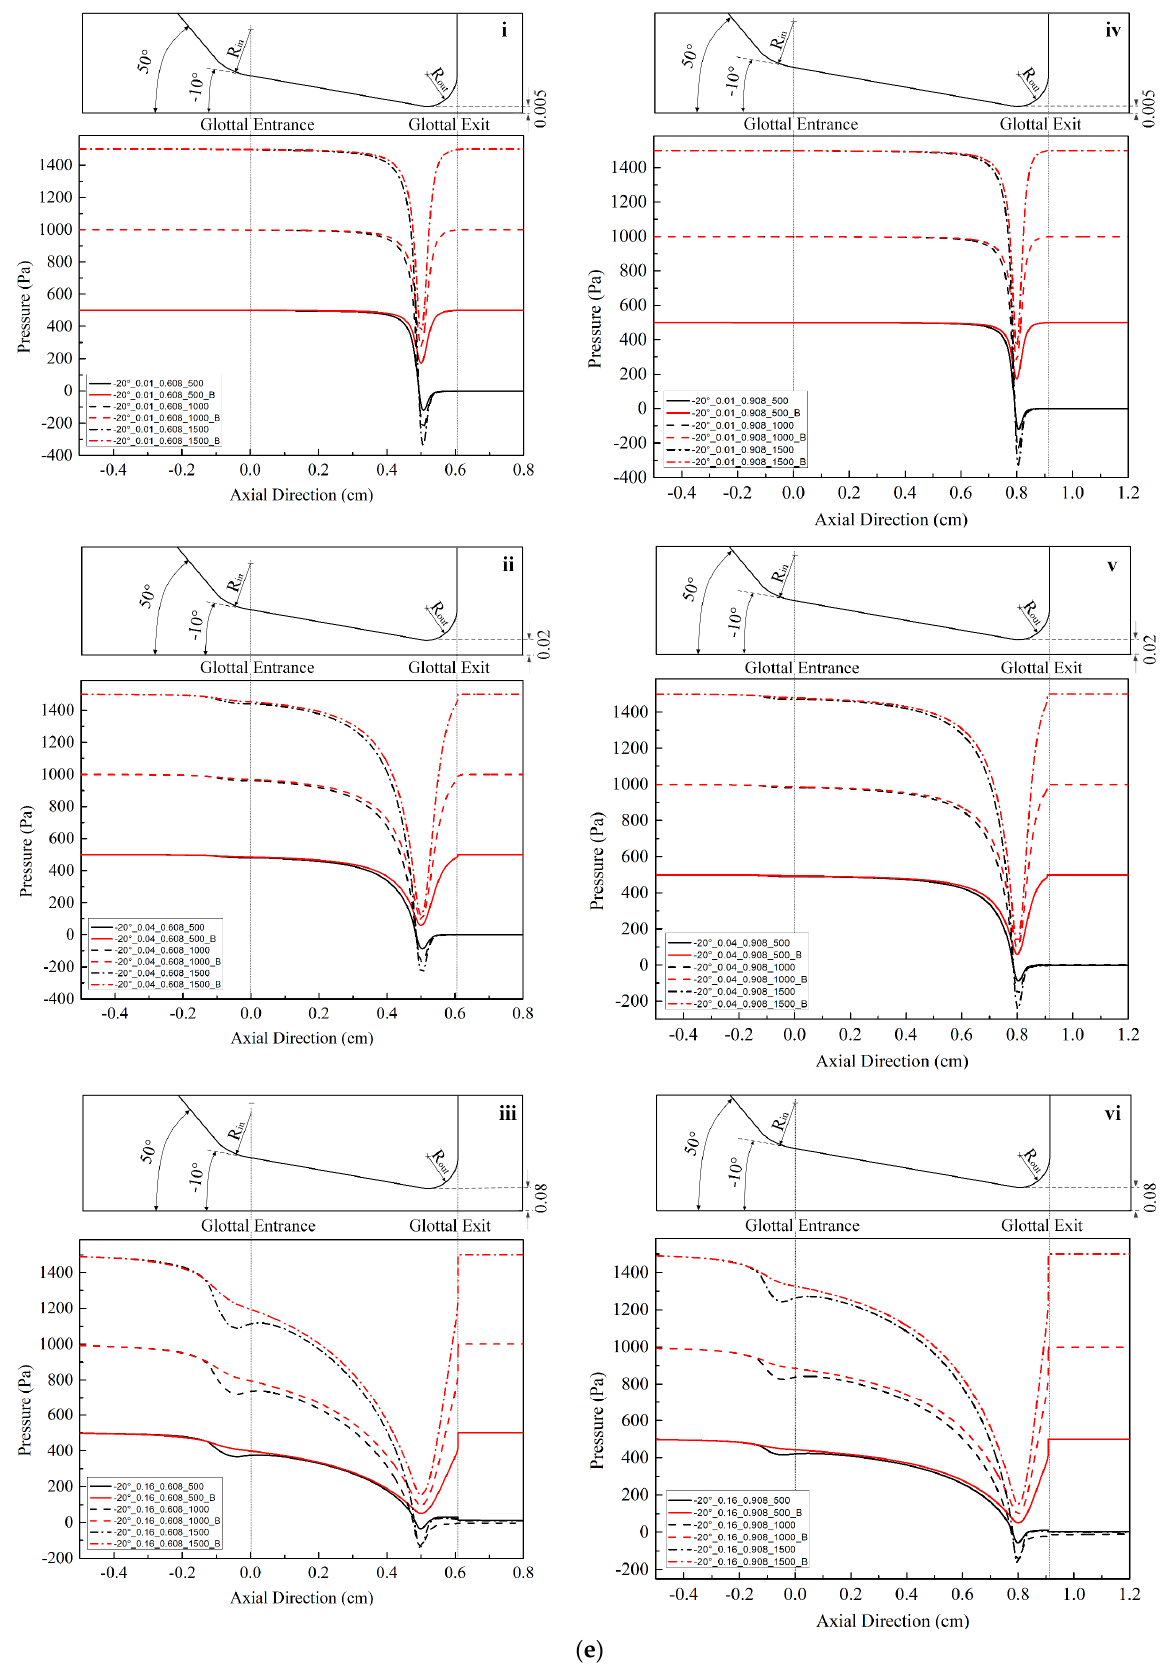
Figure 2. (Color online) Schematic of the glottal configurations and the corresponding pressure distributions for 0.108 cm (for zero glottal angle), 0.308 cm, 0.608 cm, and 0.908 cm vertical glottal duct length for − 5 ◦ , − 10 ◦ , and − 20 ◦ convergent